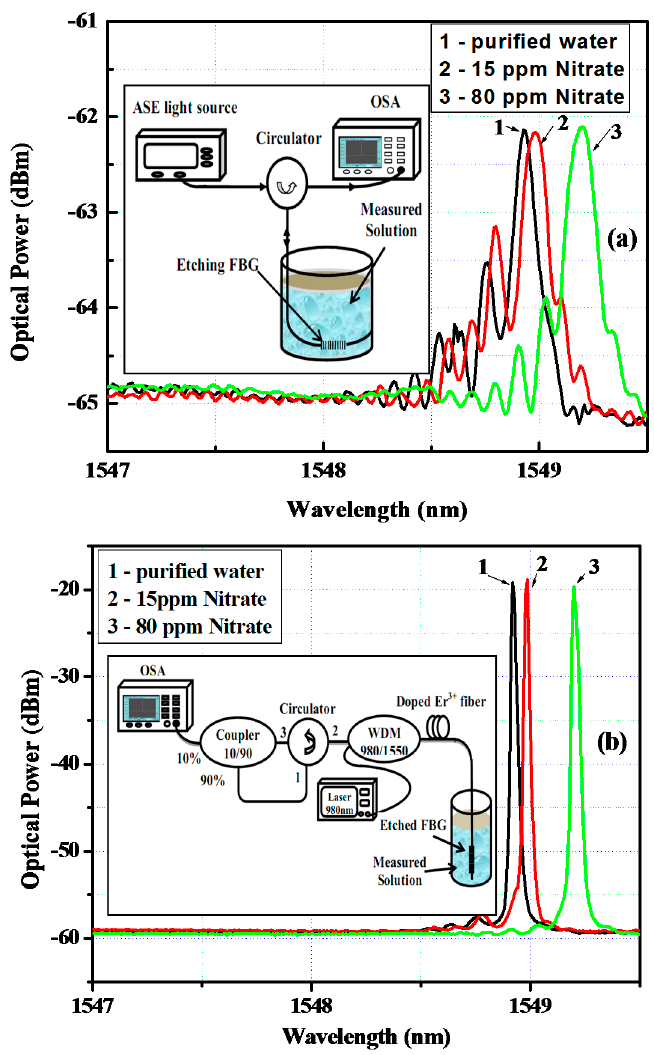
Figure 4. The spectral responses of ( a ) e-FBG from reflected configuration; and ( b ) of e-FBG integrated fiber laser configuration. The − 3 dB-bandwidths of spectra decreased from 0.55 nm to 0.02 nm, and optical signal-to-noise ratio (OSNR) increased from 3 dB to 40 dB.